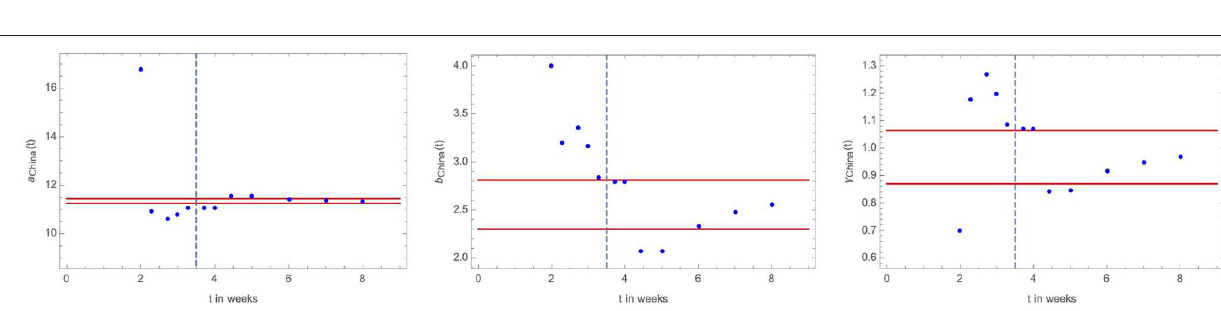
FIGURE 5 | Fit parameters to China COVID-19 data as function of time. (Left) a ( t ) with the red band corresponding to a change of 0.1 in the asymptotic value of a . This translates into a 10 % change in the asymptotic number of infected cases. (Center, Right) b ( t ) and γ ( t ) with the red band corresponding to a 10 % change in their asymptotic value. The vertical dashed blue line marks the occurrence of the inflection point in the infected cases.